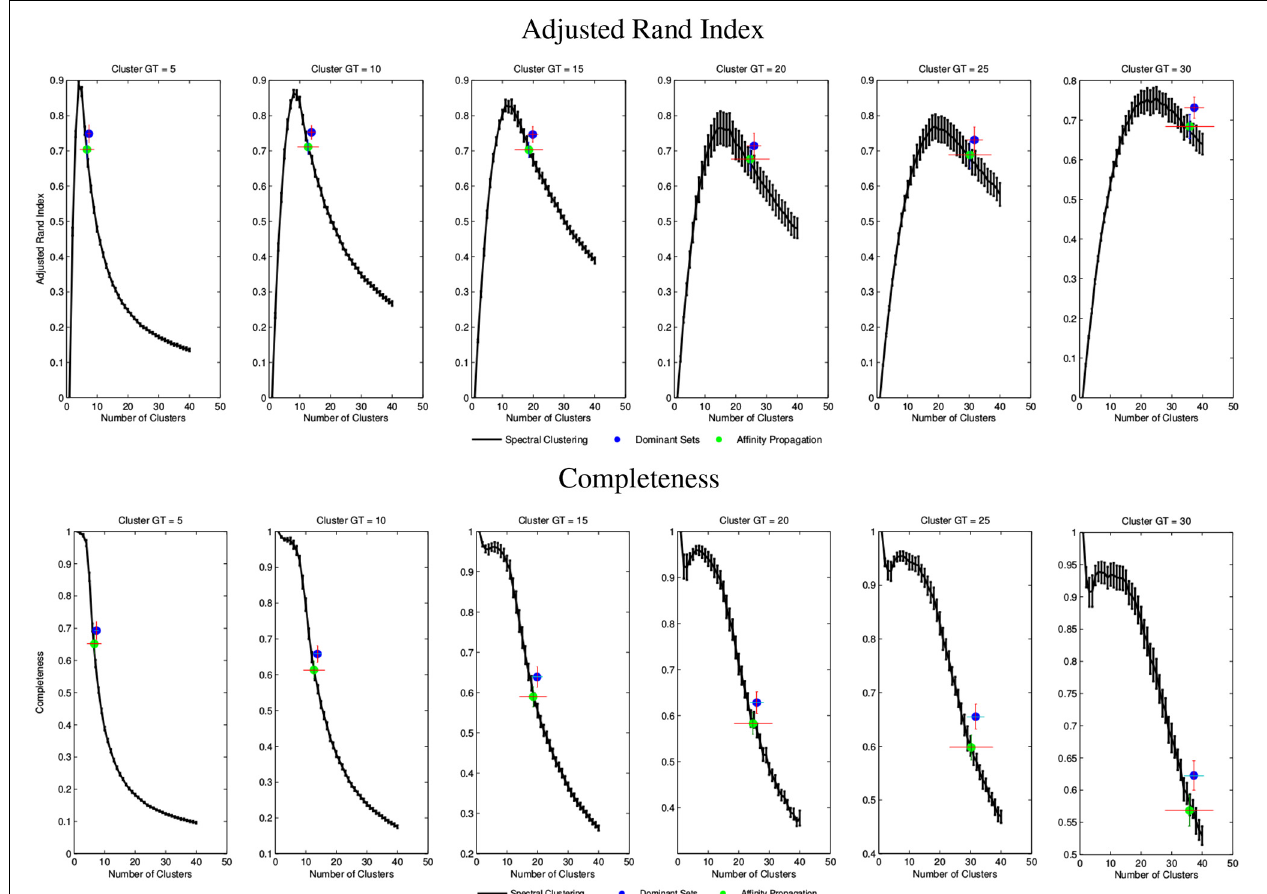
FIGURE 5 | Top Evaluation and comparison of DS through Adjusted Rand Index. Bottom: Evaluation and comparison of DS through Completeness. Black curve shows Spectral Clustering performance and standard